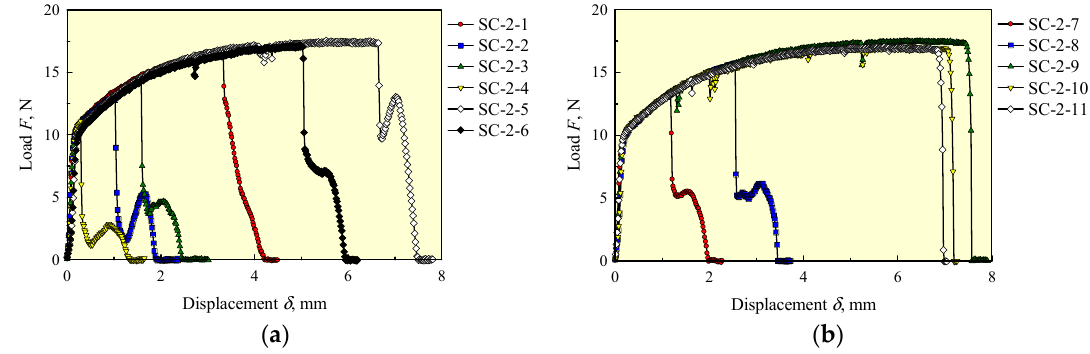
Figure 4. Load-displacement diagrams: ( a ) Specimens SC-2-1 to 6; ( b ) Specimens SC-2-7 to 11.